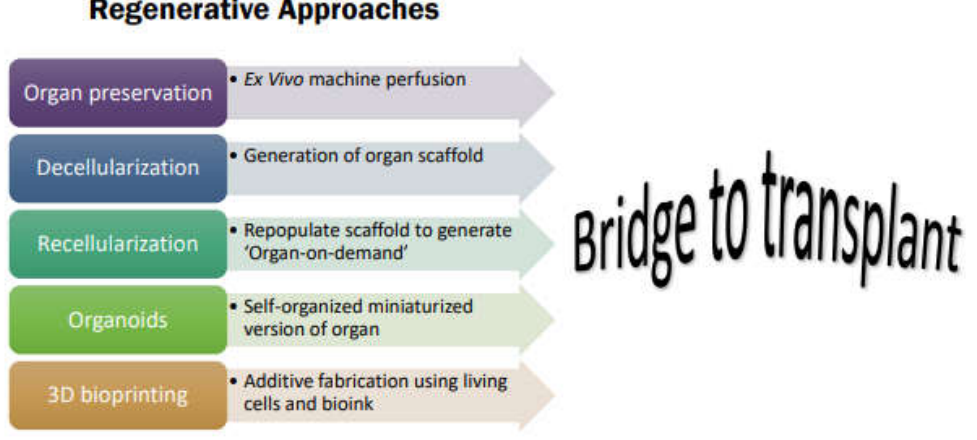
Figure 3. Schematic representation of novel technologies in tissue engineering and regenerative medicine using MSC as a bridge to organ transplantation.